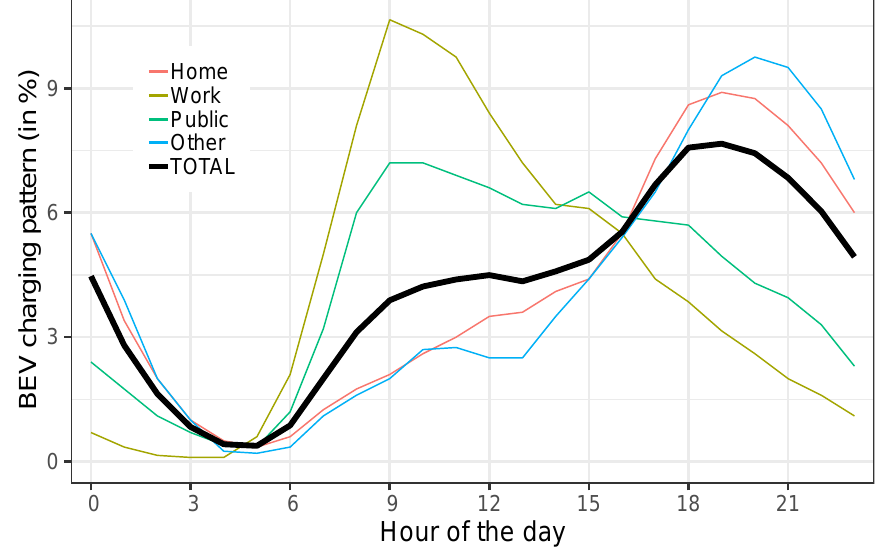
Figure 9. Hourly recharging profile of battery electric vehicles (BEVs) with shares of 70% at home, 15% at work, 10% in public (places) and 5% others according to Robinson et al. [51] and no load shifting strategies